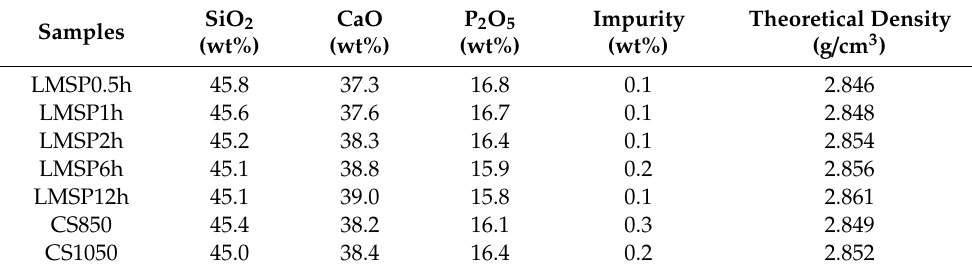
Table 1. Composition of low-temperature mineralization sintering process (LMSP) samples and conventionally sintered bioactive glass nanoparticles (BGNPs) (wt%) and their theoretical densities (g / cm 3 ) calculated by the mixture